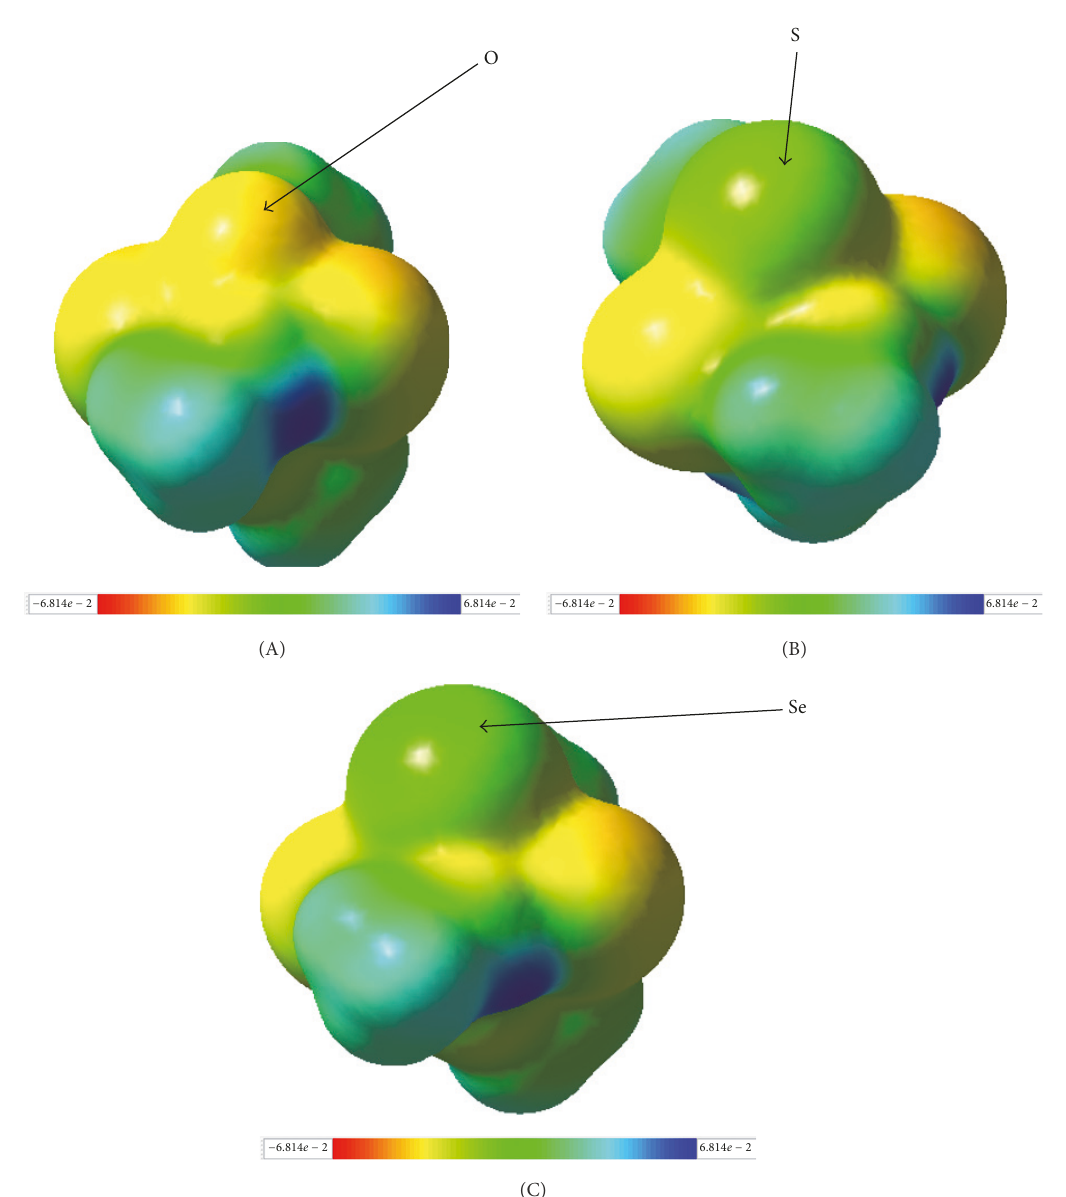
Figure 2: The molecular electrostatic potential, in Hartrees, at the 0.001 electron Bohr −3 isodensity surface of the respective complexes. A: VOCl 2 (OMe)(HOMe) 2 , B: VSCl 2 (OMe)(HOMe) 2 , and C: VSeCl 2 (OMe)(HOMe) 2